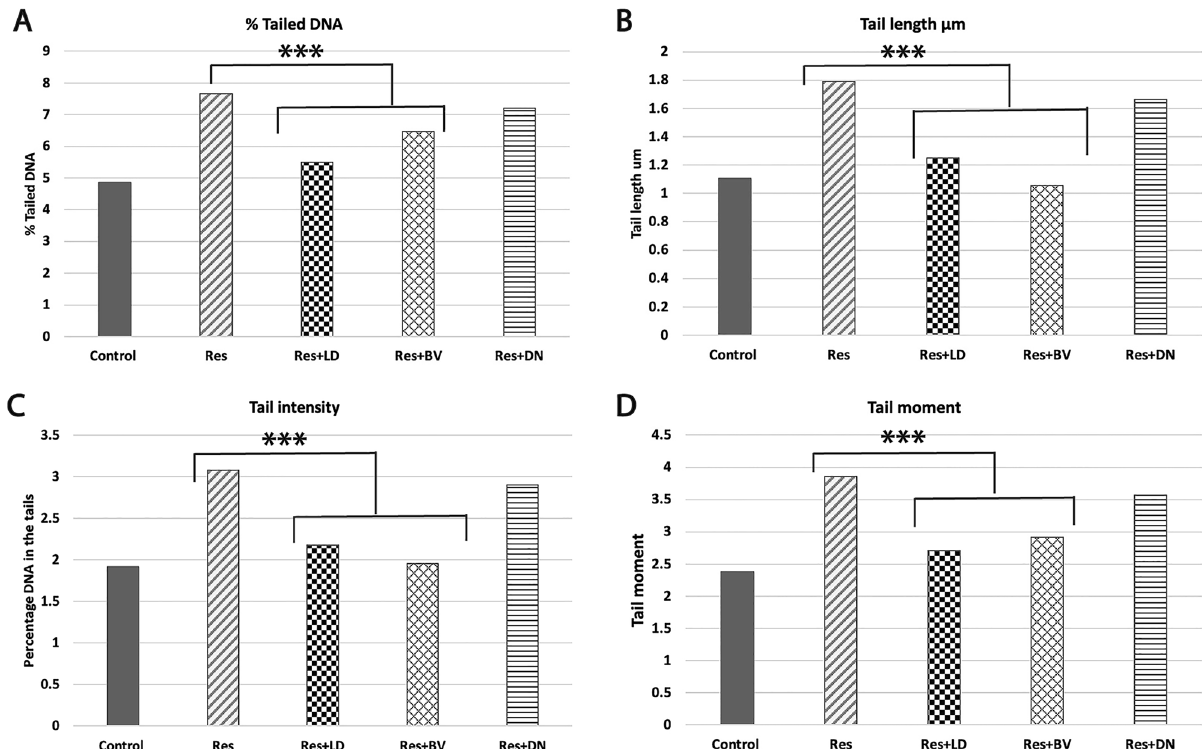
Figure 4. Effects of L-Dopa, BV, DA-nanoparticles against reserpine-induced DNA damage using DNA Comet assay. ( A ) % of tailed DNA, ( B ) tail length in um, ( C ) tail intensity that indicates the percentage of DNA in the tail, ( D ) tail